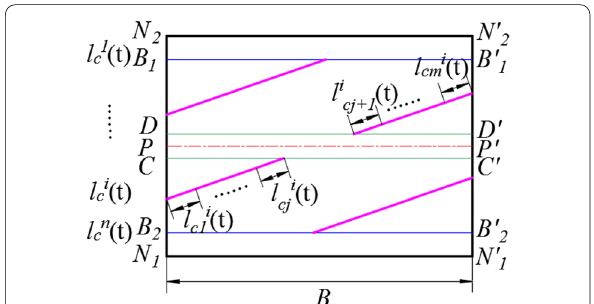
Figure 5 Contact line division schematic diagram of double involute gear pair